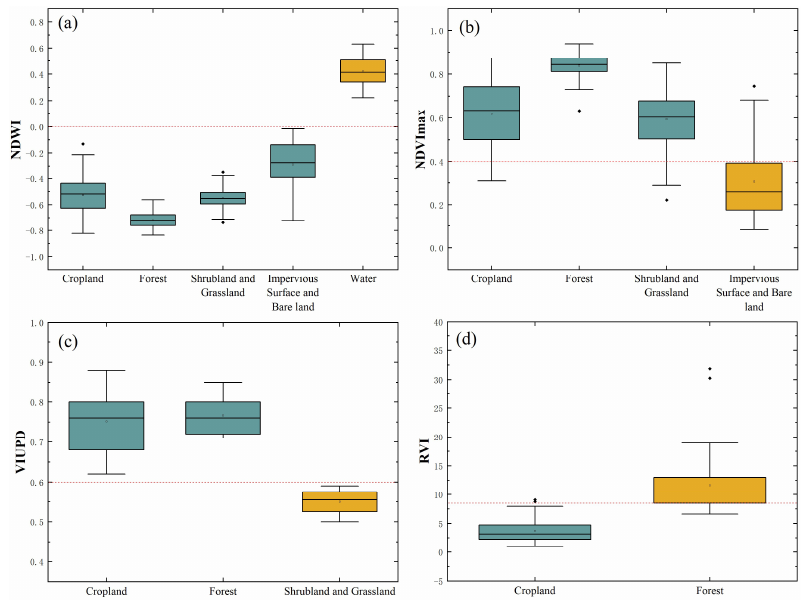
Figure 9. Box diagram of remote sensing index of typical surface features. ( a ) NDWI can distinguish water from other surface features when the threshold is 0. ( b ) NDVI synthesized by the annual maximum value can distinguish impervious surface and bare land from vegetation when the thresh- old is 0.4. ( c ) VIUPD index (mainly including cultivated land, forest land, shrubland, and grassland) can distinguish shrubland and grassland from the other two types of land when the threshold is 0.6. ( d ) RVI statistical value of cultivated land and forest land samples demonstrates good separation when the threshold is 8.5. Finally, the distribution map of cultivated land is obtained. (The yellow boxes show the indices values of identified ground features, and the green boxes show the indices values of other land use types.)